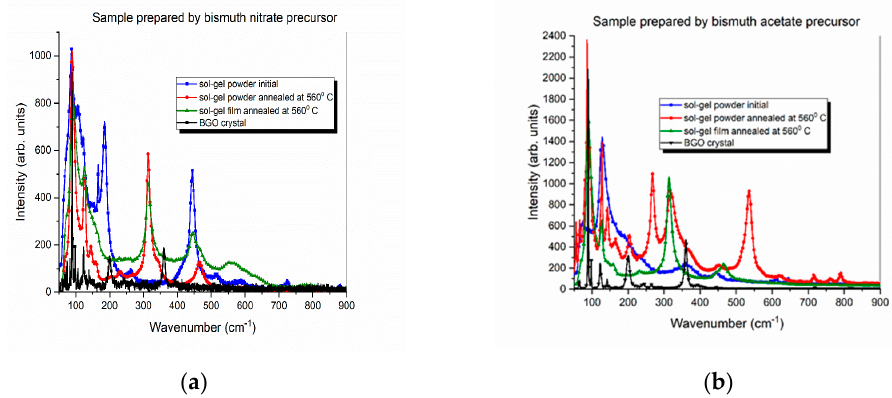
Figure 6. ( a ) Raman spectra of the sample prepared by the bismuth nitrate precursor; ( b ) Raman spectra of the sample prepared by the bismuth citrate precursor.